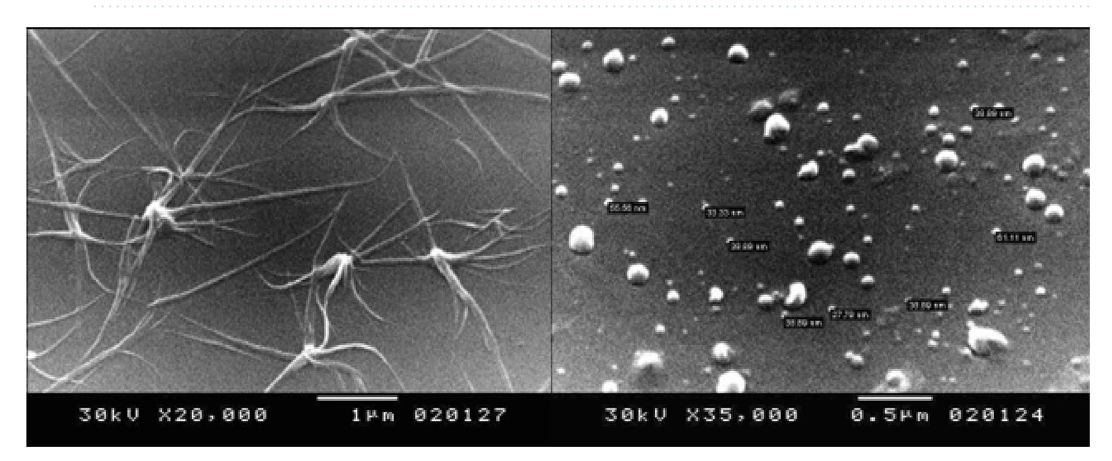
Figure 4. SEM images of the mixed ligand